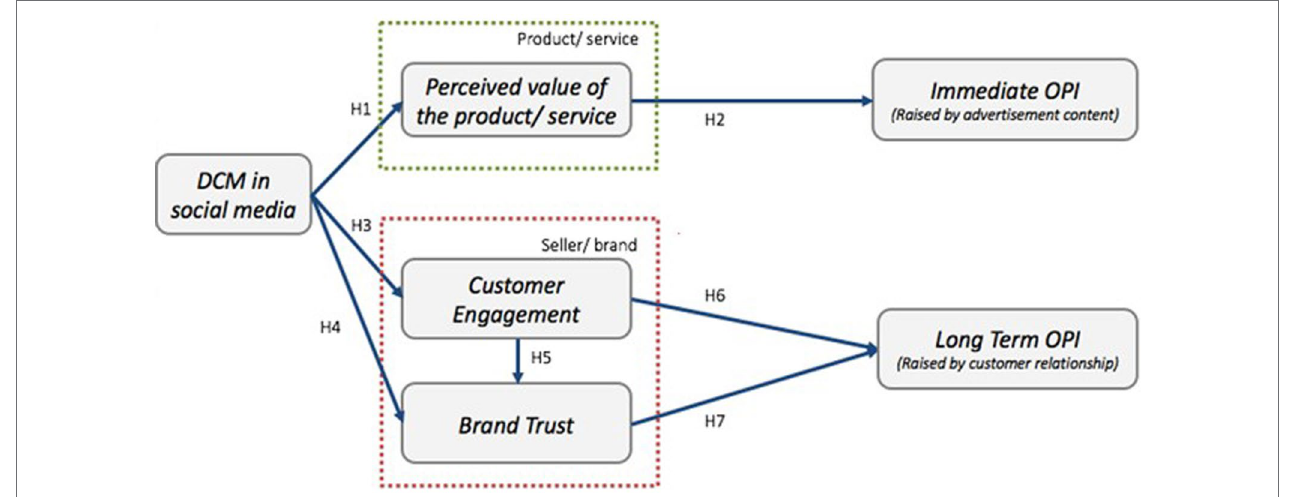
FIGURE 2 | Conceptual model: digital content marketing